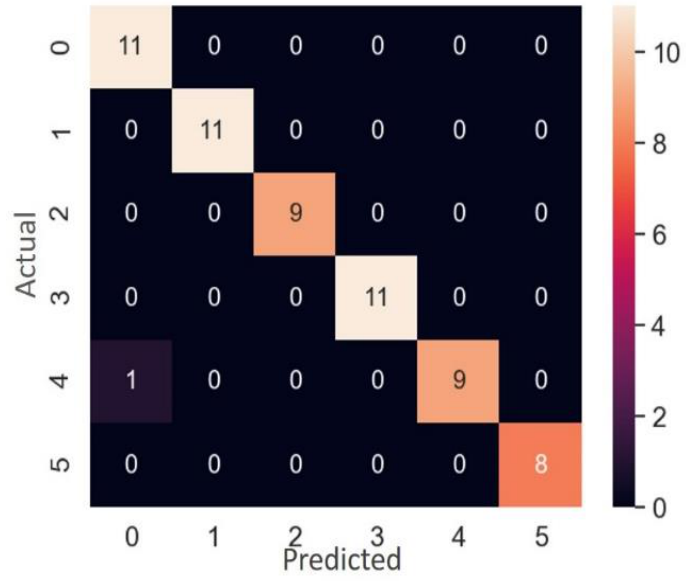
Figure 18. Confusion matrix of random forest single-factor classification results.